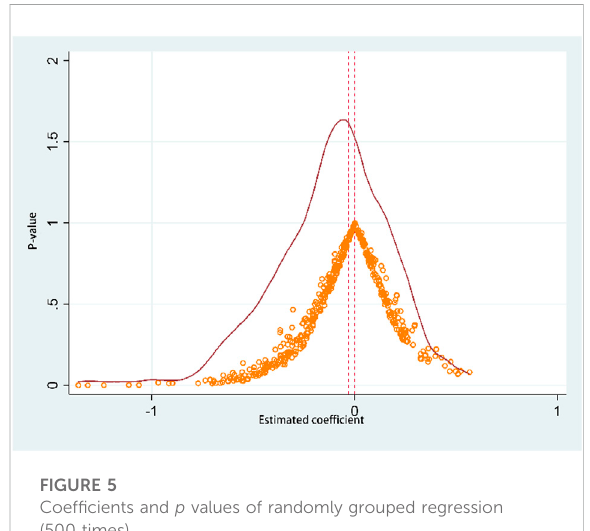
FIGURE 5 Coef fi cients and p values of randomly grouped regression (500 times).